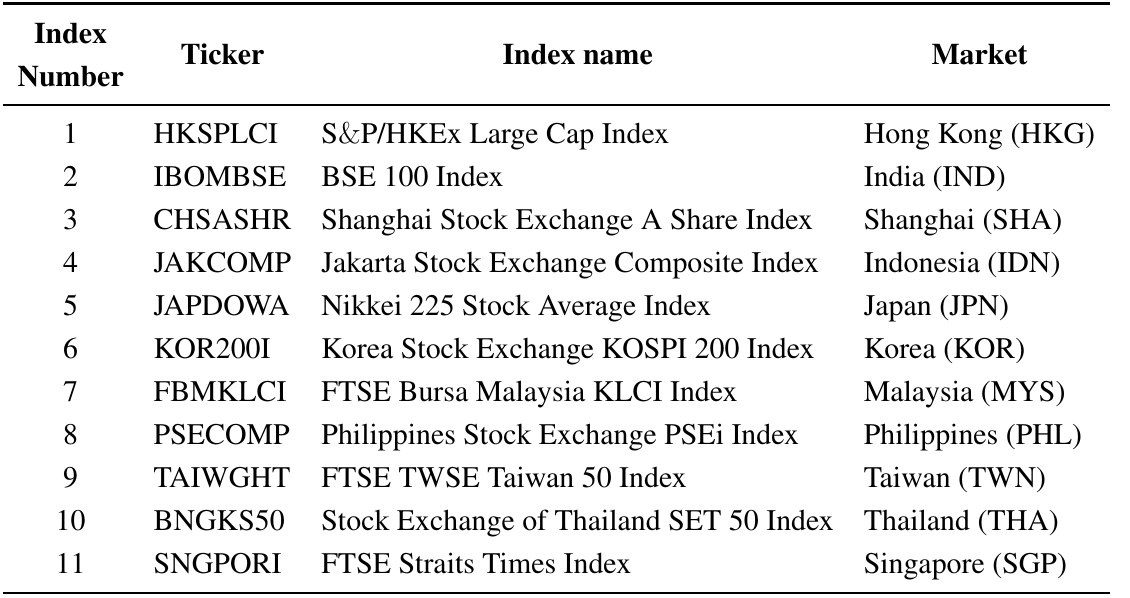
Table 3. Ticker symbols, Index names, and the corresponding